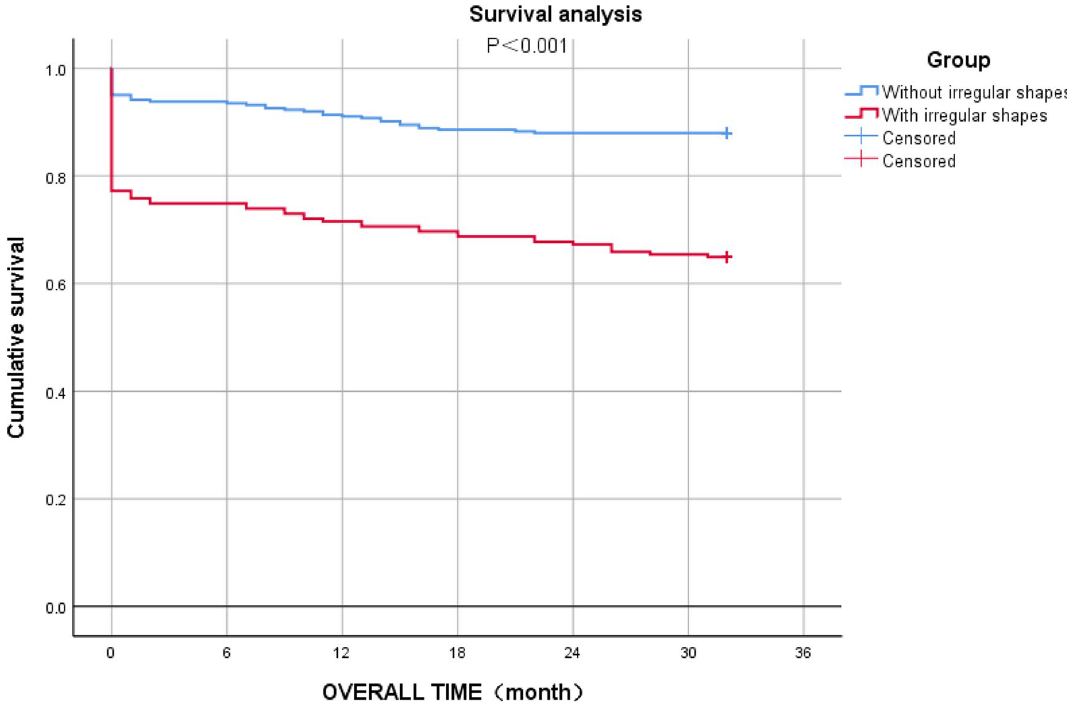
Figure 5. Scatter plot showing the relationship between the irregular shape and plasma D-dimer expression level. The appearance of irregular shapes in patients is often accompanied by an increase in plasma D-dimer expression on